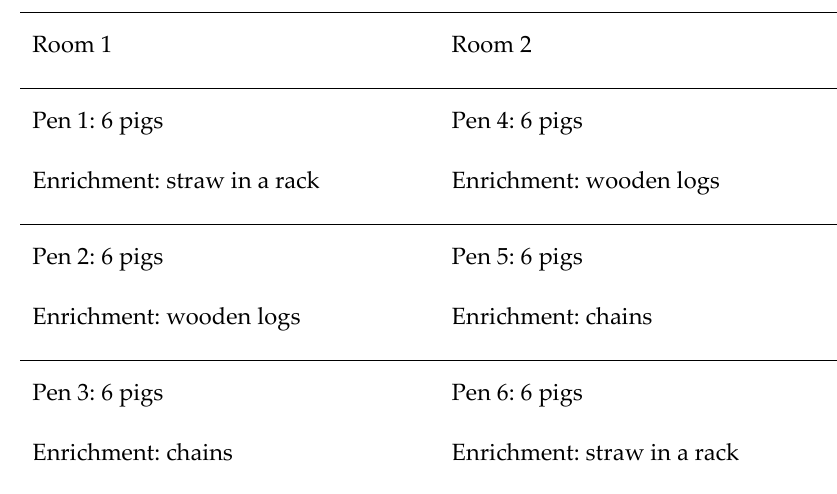
Figure 1. Distribution of different types of enrichment material.